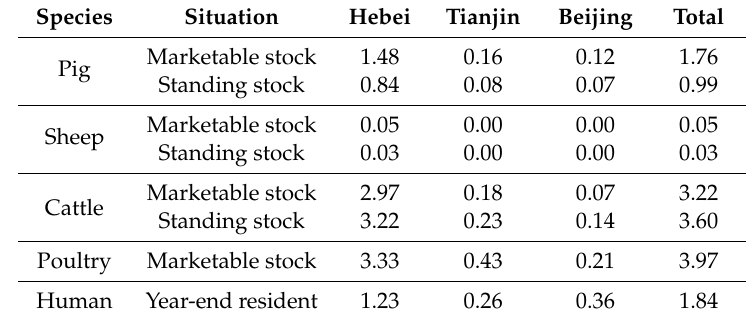
Table 8. The estimated COD production of human, livestock, and poultry waste (10 6 tons).